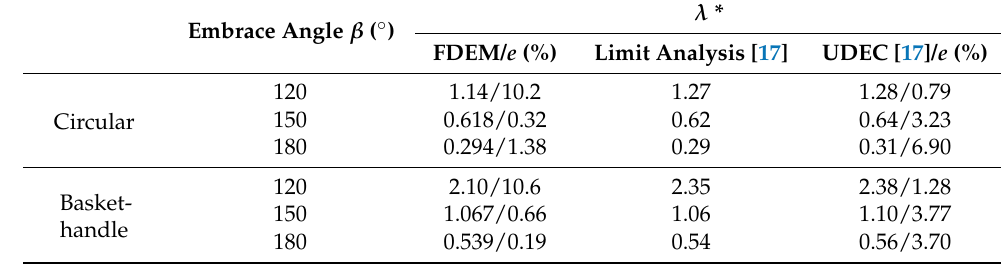
Table 2. λ * of circular and basket-handle arches without buttresses.